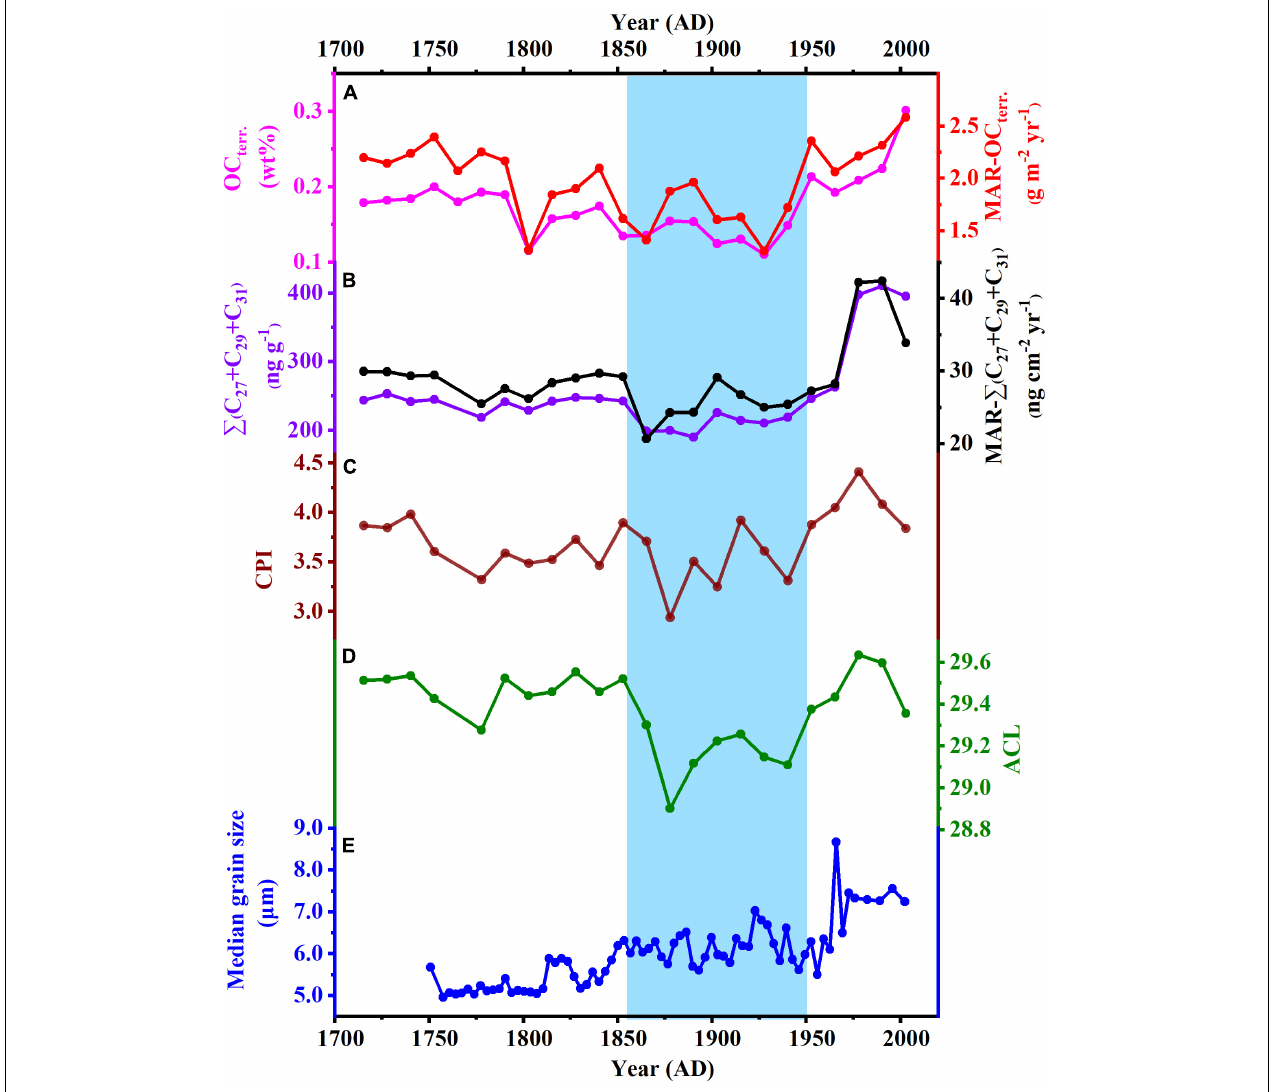
FIGURE 4 | Terrestrial OC records and n -alkanes indexes from core HH12 and median grain size from core 35009. (A) Content (pink) and mass accumulation rate (MAR) (red) of terrestrial OC calculated by TOC- δ 13 C mixing model from core HH12 (this study). (B) Content (purple) and MAR (black) of (cid:54) (C 27 + C 29 + C 31 ), i.e., sum of long chain of n -alkanes C 27 , C 29 , C 31 , from core HH12 (this study). (C) Carbon preference index (CPI) from core HH12 (this study). CPI = 0.5 × (C 25 + C 27 + C 29 + C 31 + C 33 )/ (C 24 + C 26 + C 28 + C 30 + C 32 ) + 0.5 × (C 25 + C 27 + C 29 + C 31 + C 33 )/ (C 26 + C 28 + C 30 + C 32 + C 34 ). (D) Average chain length (ACL) from core HH12 (this study). ACL = (25 × C 25 + 27 × C 27 + 29 × C 29 + 31 × C 31 + 33 × C 33 )/ (C 25 + C 27 + C 29 + C 31 + C 33 ). (E) Median grain size from core 35009 (Zhou X. et al., 2014). Content of long chain n -alkanes was expressed in ng per g dry sediment (ng g − 1